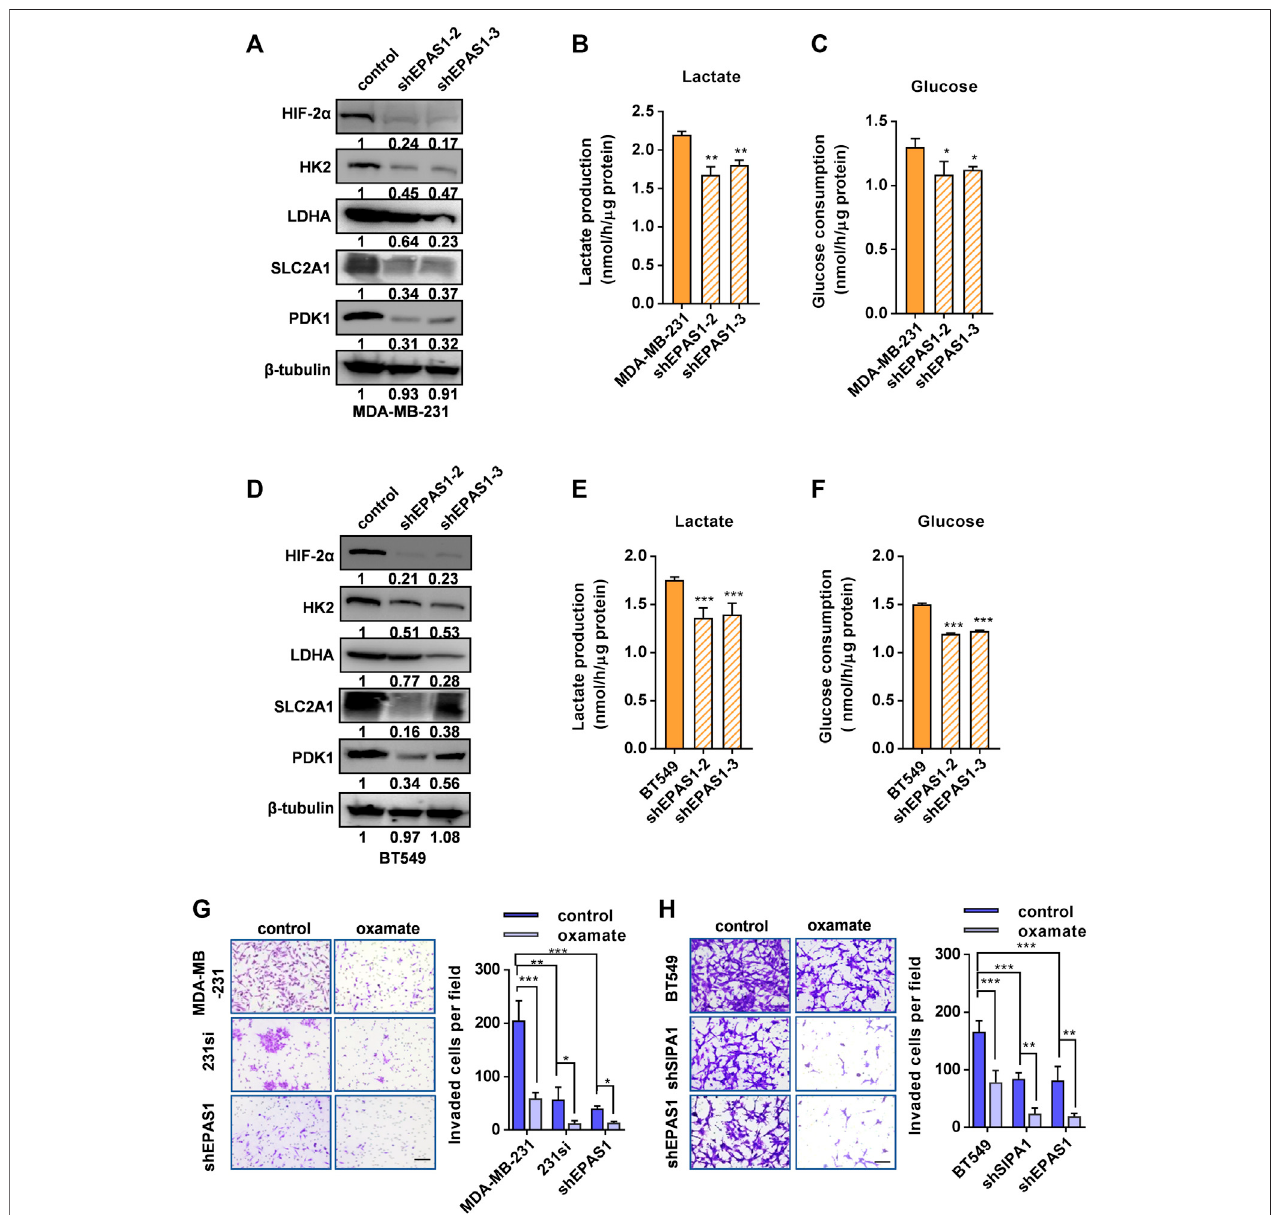
FIGURE 4 | Knocking down HIF-2 α suppresses aerobic glycolysis and invasion of breast cancer cells. (A) HIF-2 α and glycolytic-related proteins in parental and HIF-2 α -knockdown MDA-MB-231 cells were determined by Western blotting analysis. β -tubulin was included as an internal control. Production of lactate (B) and glucoseconsumption (C) inparentalandHIF-2 α knockdownMDB-MB-231cells. (D) HIF-2 α andglycolysis-relatedproteinlevelsweredeterminedbyWesternblottingin parental and HIF-2 α knockdown BT549 cells. β -tubulin was included as an internal control. Production of lactate (E) and glucose consumption (F) in parental and HIF-2 α knockdown BT549 cells. (G – H) Invasion of MDA-MB-231 (G) and BT549 (H) and their derivatives treated with or without 20 mM oxamate was analyzed by a transwell assay sistern. Data are shown as mean ± s.d of triplicate measurements (n (cid:1) 3). * p < 0.05, ** p < 0.01, *** p < 0.001. (Student ’ s t -test).